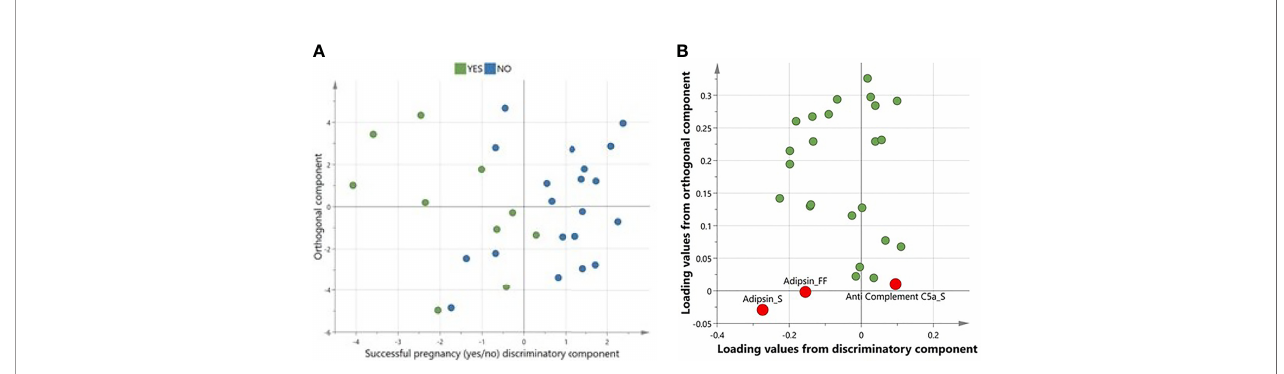
FIGURE 2 | A multivariate OPLS-DA con fi rming complement factors differentiating successful from unsuccessful pregnancies. (A) Scores plot from OPLS-DA showing discriminatory and orthogonal components for successful vs unsuccessful pregnancies. (B) Corresponding loadings plot from OPLS-DA. Signi fi cantly different complements are highlighted in red.